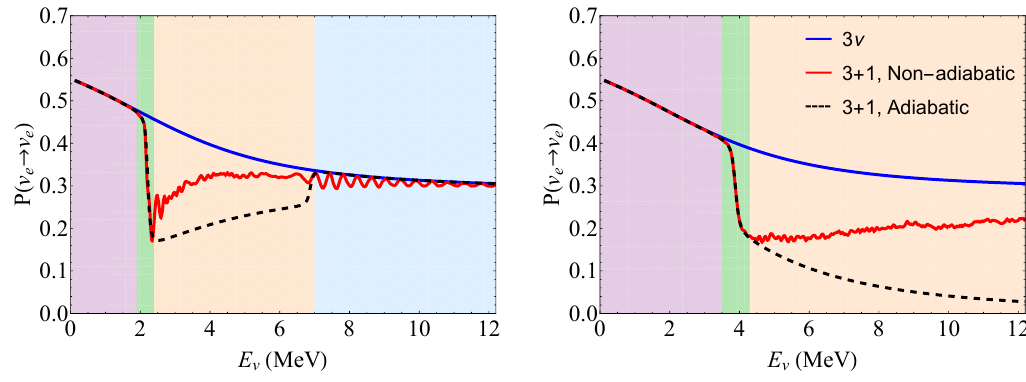
Figure 1 . Survival probabilities of solar neutrinos as a function of neutrino energy. Here we take sin 2 2 θ 01 = 5 × 10 − 4 , and R ∆ = 0 . 15 ( 1 . 20 ) in the left (right) panel. Other sterile neutrino parameters are set to be zero, and the oscillation parameters of active neutrinos are set at the best-fit values from the global fit in ref. [38]. The red solid curves are obtained by using the numerical method in the 3+1 framework. The analytical solution in the 3+1 (3 ν ) case under the assumption of adiabatic propagation is also shown as the black dashed (blue solid) curves for comparison. The colored regions are divided by different resonance energies; see the text for